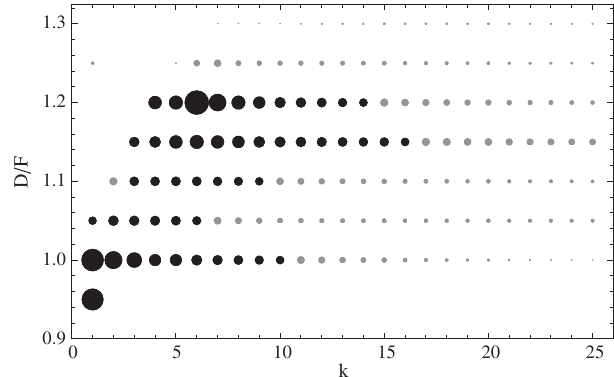
FIG. 51. The acceptances for 30 m of transport line using cells with nonscaling magnets in a FDDF configuration. See Fig. 50 for description of dot size and color.